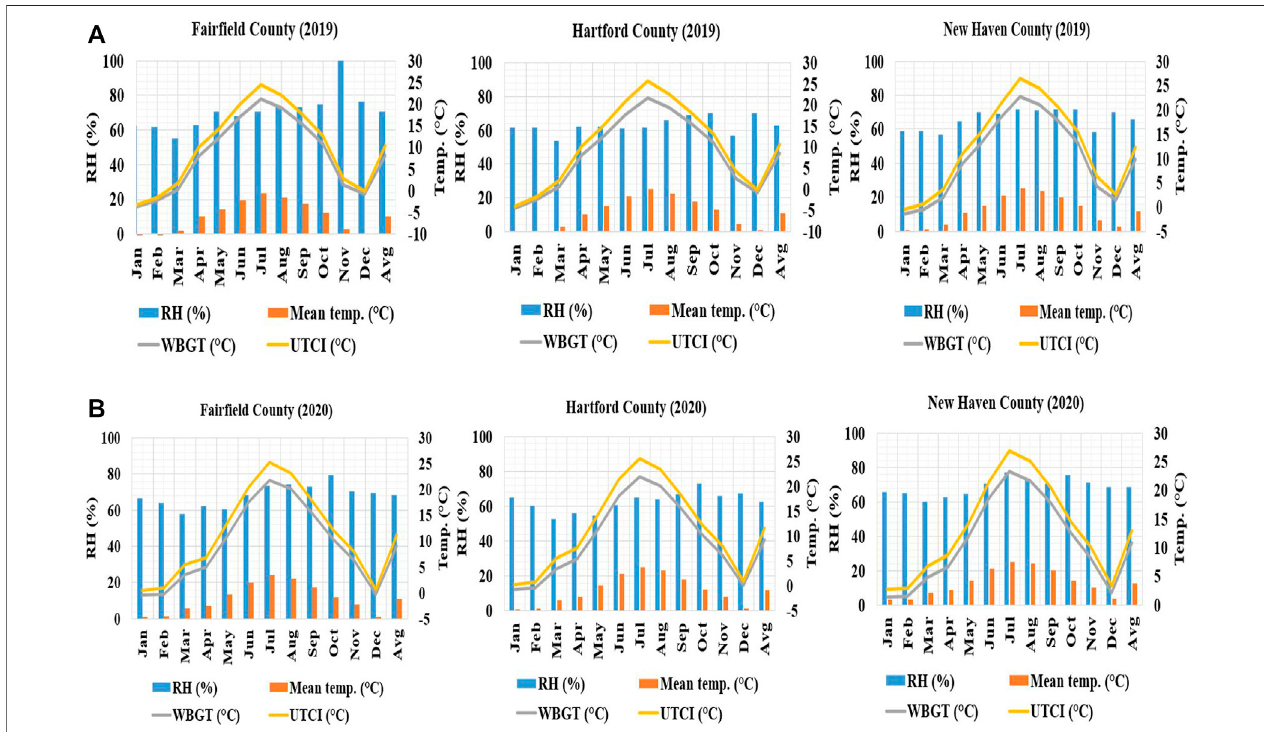
FIGURE 9 | (A) : Links between mean RH, temperatures, and thermal indices in Fair fi eld (left) , Hartford (middle) , and New Haven (right) in 2019 (pre-pandemic year). (B) : Links between mean RH, temperatures, and thermal indices in Fair fi eld (left) , Hartford (middle) , and New Haven (right) in 2020 (pandemic year).